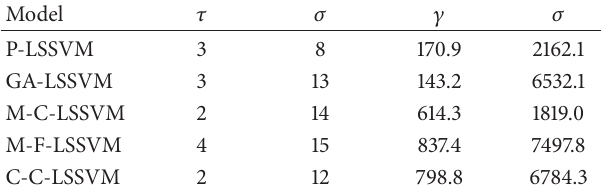
Table 2: The optimal parameters combination of five models for interphone